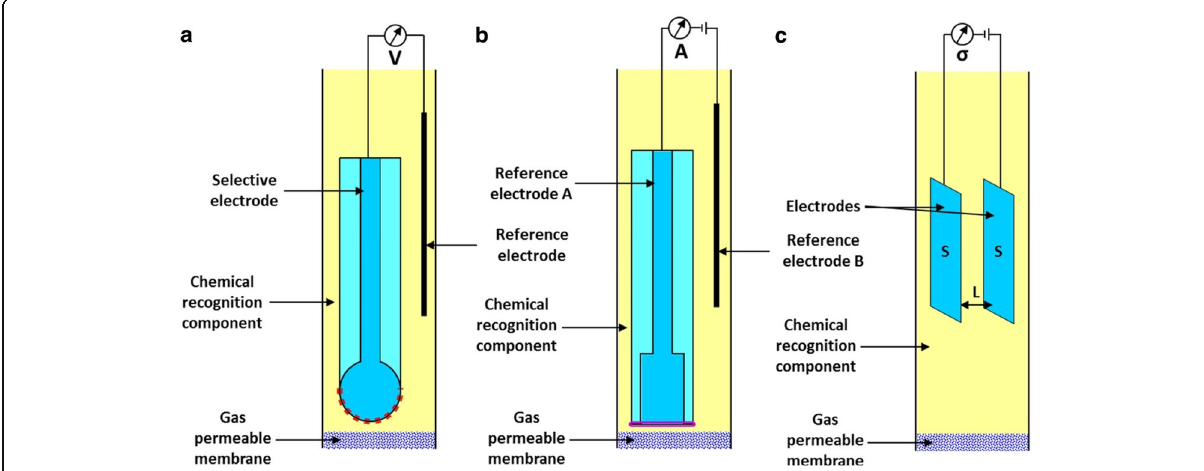
Fig. 2 Schematic diagrams of three typical membrane-based electrochemical gas sensors. a Potentiometric sensor. b Amperometric sensor. c Conductometric sensor. (Reprinted with permission from Reference Li et al. 2017). © 2017